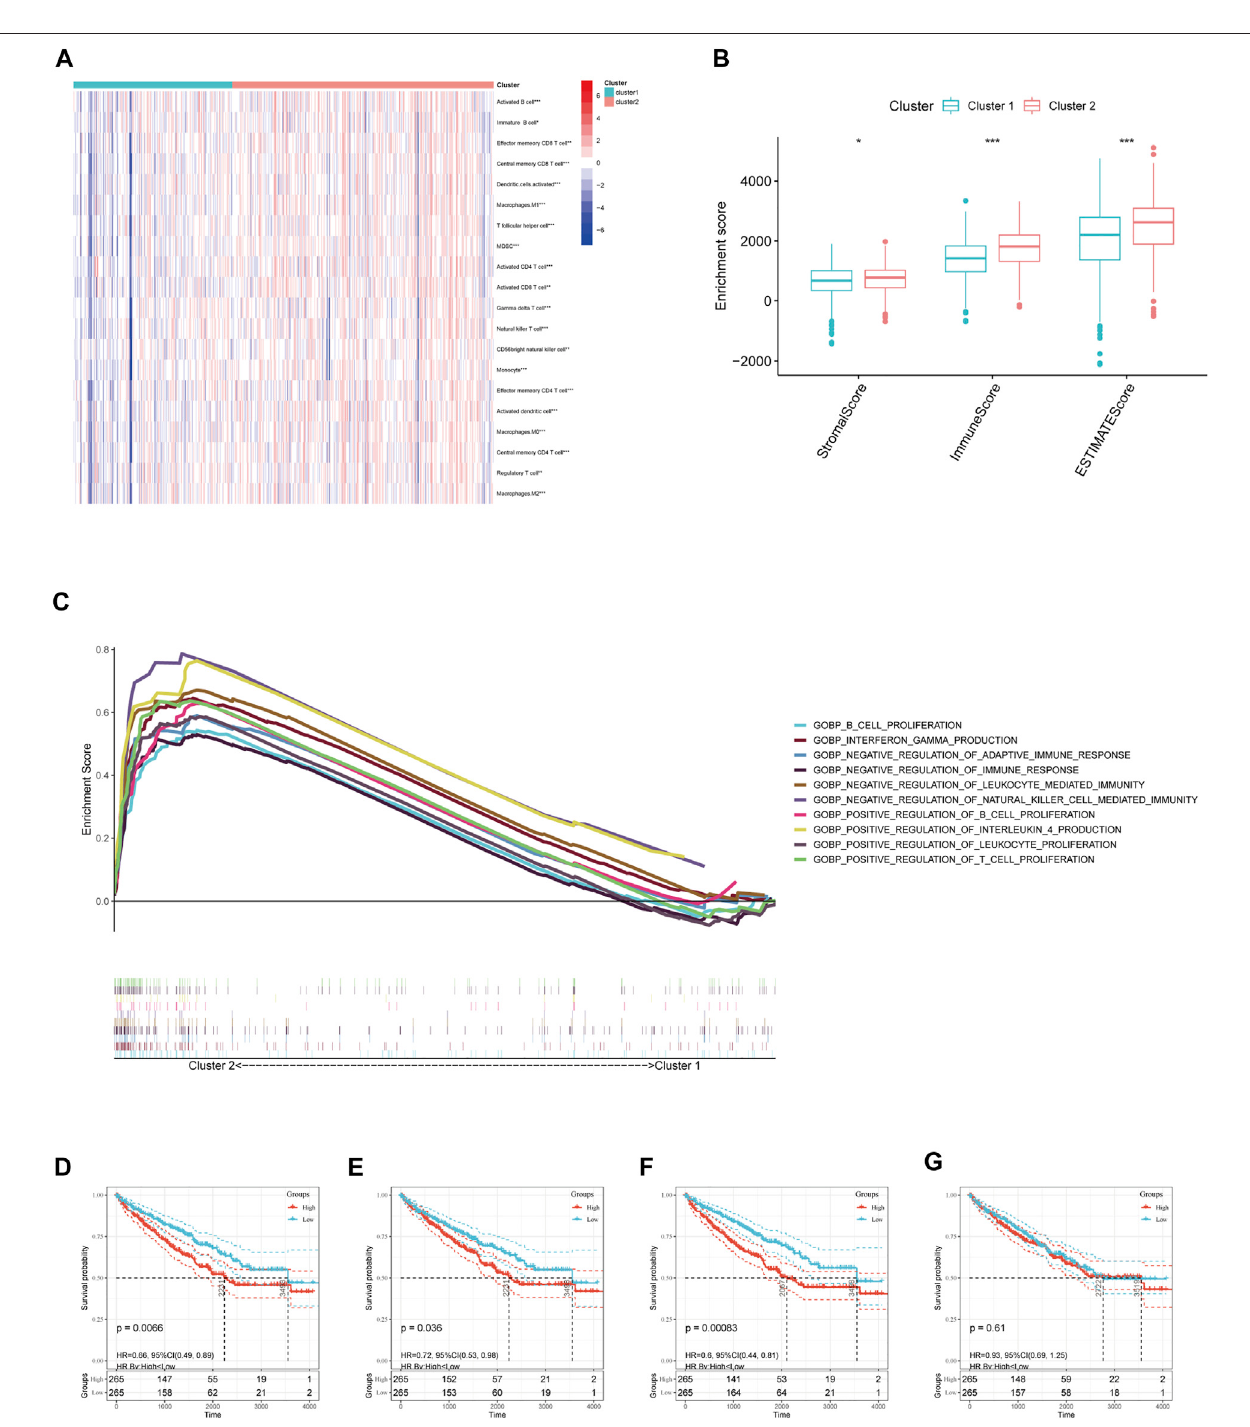
FIGURE 3 | Immune cell in fi ltration analysis and GSEA analysis between different clusters. (A) Estimated abundance of 20 immune cells using ssGSEA. (B) Tumor microenvironment(TME)estimatescoreindifferentclusters. (C) GSEAdelineationofthebiologicalpathwayswhichenrichincluster2usingthegeneset “ c5.go.bp.v7.4. symbols ” .OverallSurvival(OS)analysisindifferentGSVAscoreof (D) negativeregulationofadaptiveimmuneresponse, (E) negativeregulationofimmuneresponse,and (F) negative regulation of leukocyte-mediated immunity, (G) negative regulation of natural killer cell-mediated immunity in TCGA-ccRCC patients. Signi fi cant statistical differences between the two clusters were assessed using the Wilcoxon test (ns, p > 0.05; *, p < 0.05; **, p < 0.01; ***, p < 0.001).